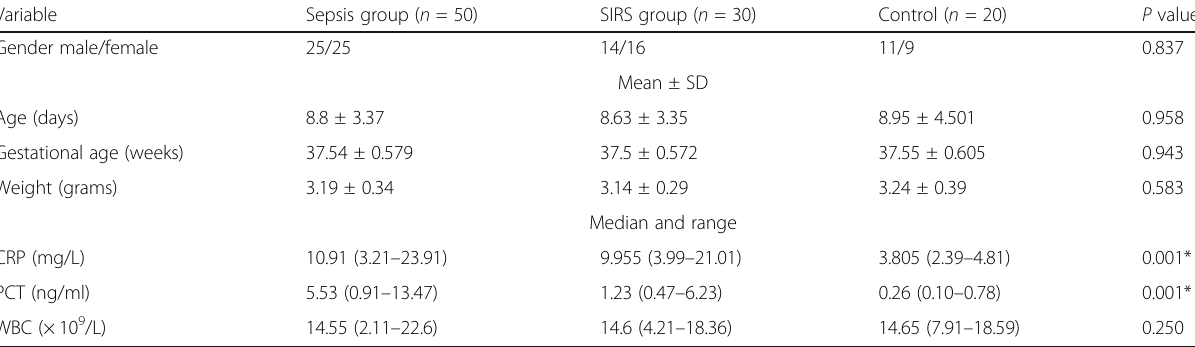
Table 1 Demographic and laboratory characteristics of the different studied groups Variable